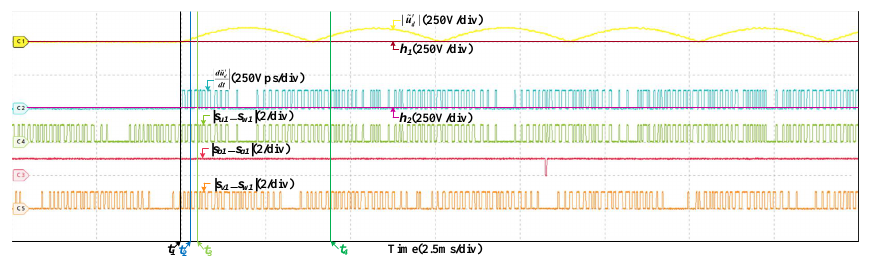
Figure 14. HIL results when the offset fault occurs in S Cu at 200